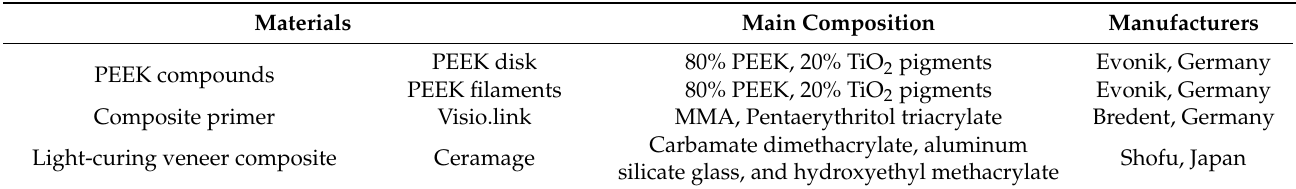
Table 1. Main experimental material